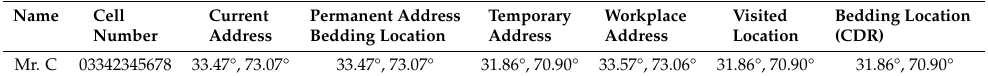
Table 6. Information gathered from the proposed